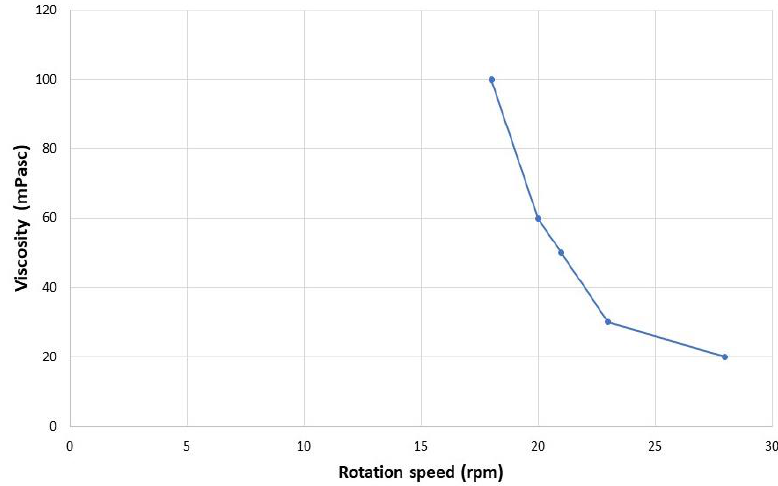
Figure 7. Effect of shear rate on viscosity (viscosity curve-pseudoplastic flow) of D-NLCs containing 0.15% (w/v) of HPMC.